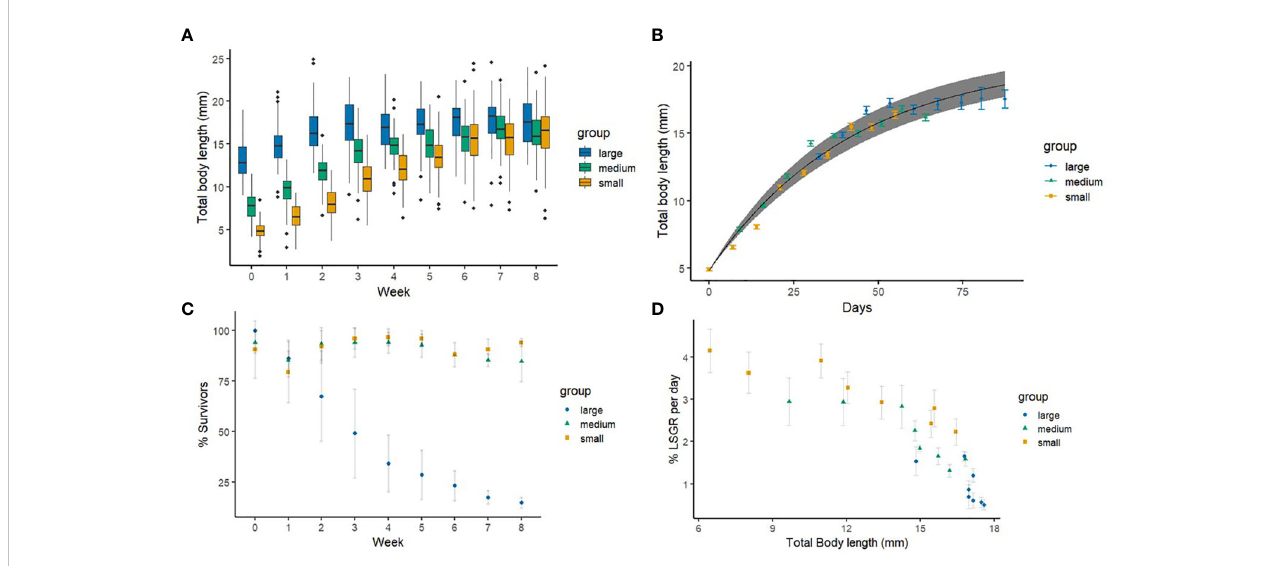
FIGURE 3 (A) Body lengths (in millimeters) for pooled polychaete groups over time with black horizontal line showing the median and vertical lines, illustrating minimum and maximum values. (B) The von Bertalanffy growth curve plotted together with measured data for mean total body length (mean ± SE) with the line for predicted mean values and 95% con fi dence interval. Polychaetae groups are plotted according to their calculated age (days). (C) Total survival (%) over time (n = 3 per group, mean ± SD). (D) Length-speci fi c growth rate (LSGR % day − 1 ) (n = 3 per group, mean ± SD). Size groups are separated by shape and color where blue circles = large, green triangles = medium, and yellow squares = small.